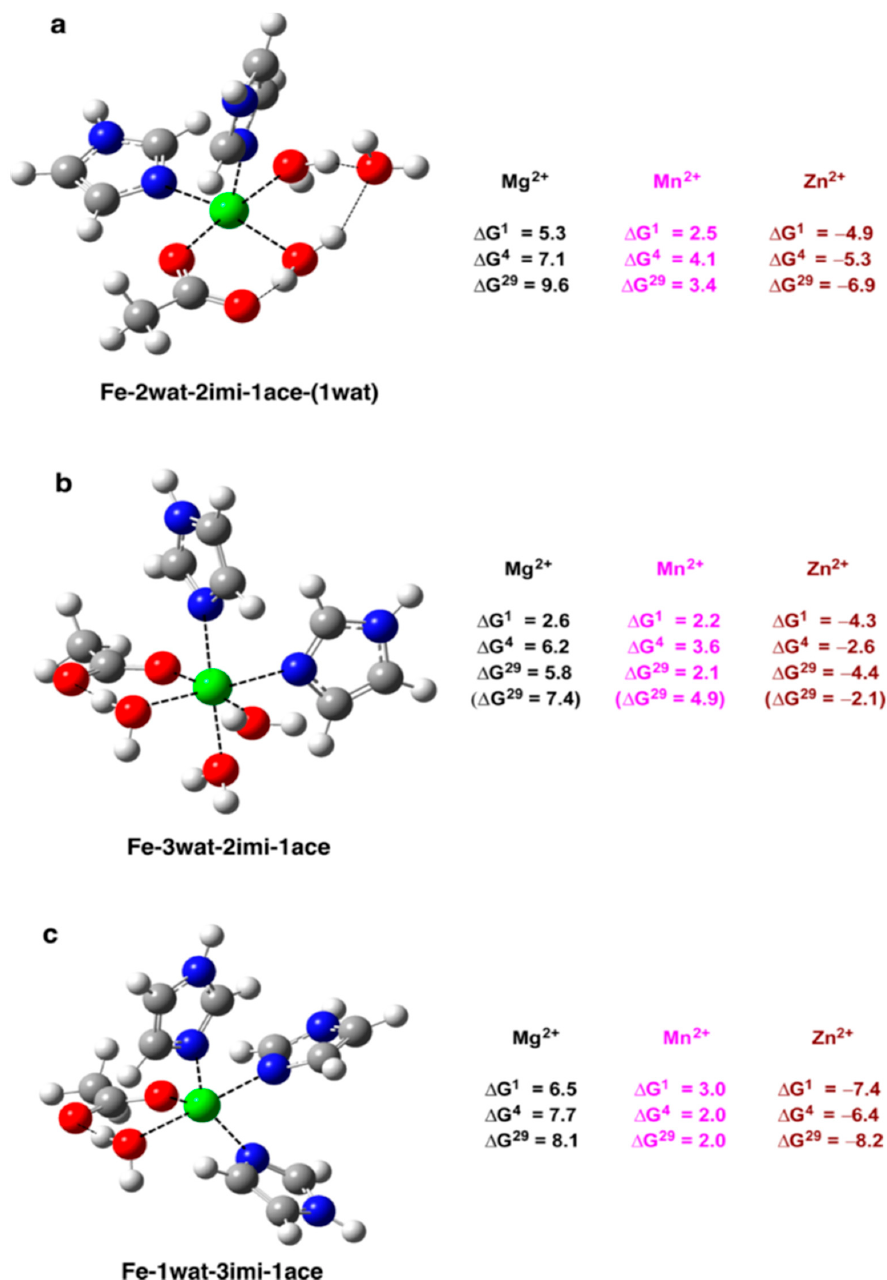
Figure 2. M06-2X/6-311++G** optimized structures of ( a ) pentacoordinated and ( b ) hexacoordinated Fe 2+ model binding sites comprising two imidazole, one acetate, and three water ligands, and ( c ) pentacoordinated metal center containing three imidazole, one acetate, and one water ligands. The free energies Δ G ε (in kcal/mol) for replacing Fe 2+ in the binding site characterized by dielectric constant ε with M 2+ (M = Mg, Mn, Zn) are shown on the right. Δ G 1 refers to cation exchange free energy in the gas phase, whereas Δ G 4 and Δ G 29 refer to cation exchange free energies in an environment characterised by effective dielectric constants of 4 (buried binding sites) and 29 (solvent accessible binding pockets), respectively. Positive Δ G ε suggests Fe 2+ ‐ selective metal center, while negative Δ G ε imply a M 2+ selective site. His residues are represented by imidazoles (‘imi’) whereas the Asp ‐ /Glu ‐ side chains are modeled as acetates (“ace”). Numbers in parentheses in Figure 2b refer to metal ion exchange in rigid Fe 2+ binding sites. Adapted from Ref. [32]. Copyright 2016 American Chemical Society.